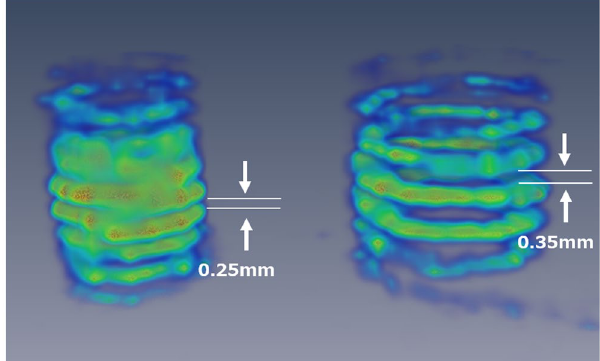
Figure 16. 3-D image of Phantom (IV).